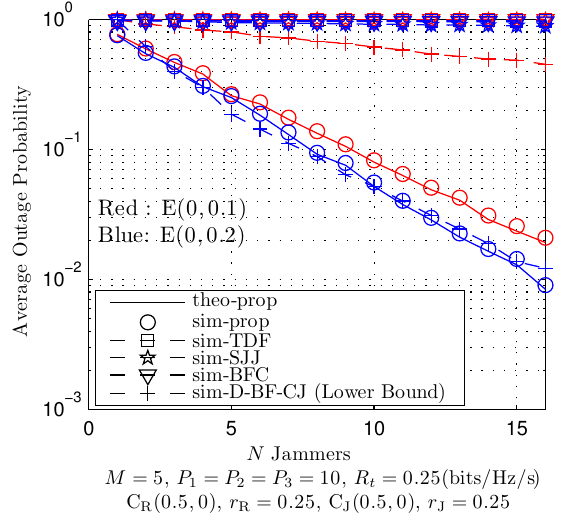
Figure 4. Outage performance in relation to the changes in the number of jammers with a fixed number of relays M = 5 .